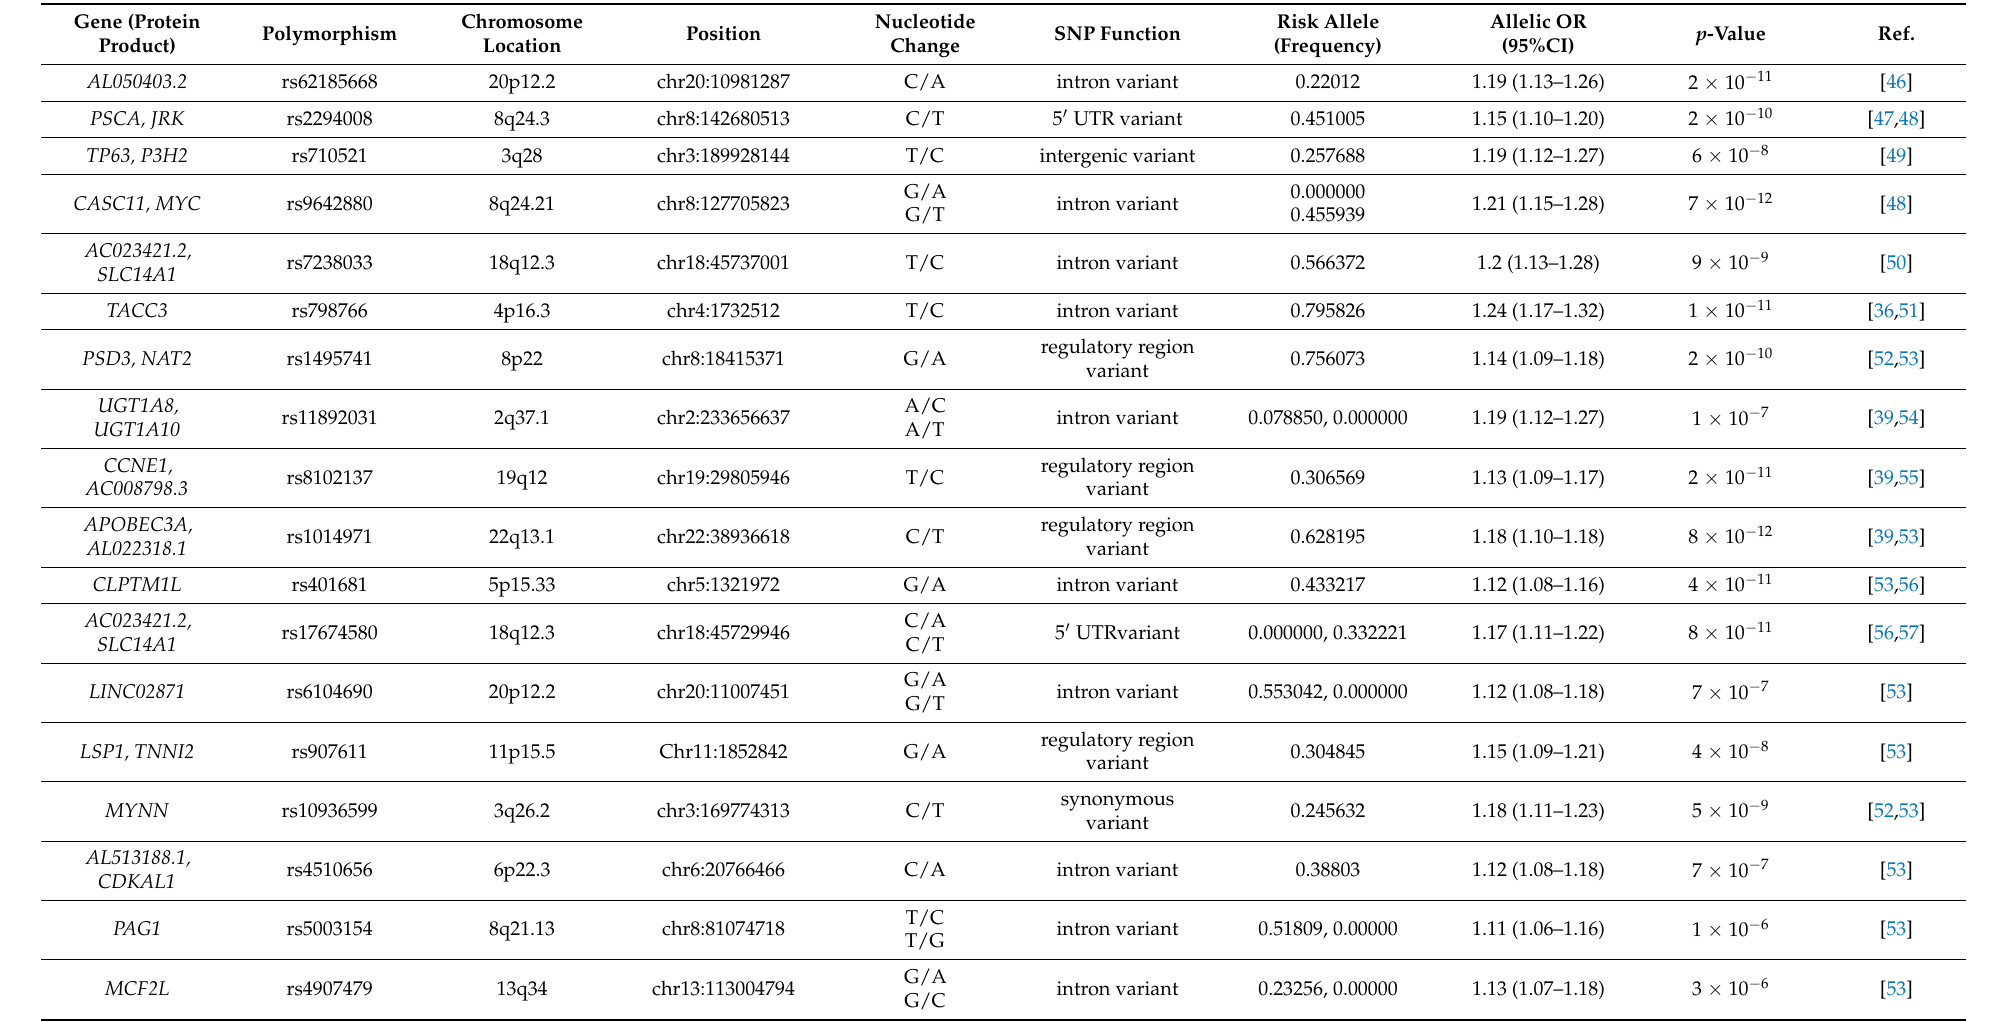
Table 1. Confirmed genetic variants associated with bladder cancer risk in